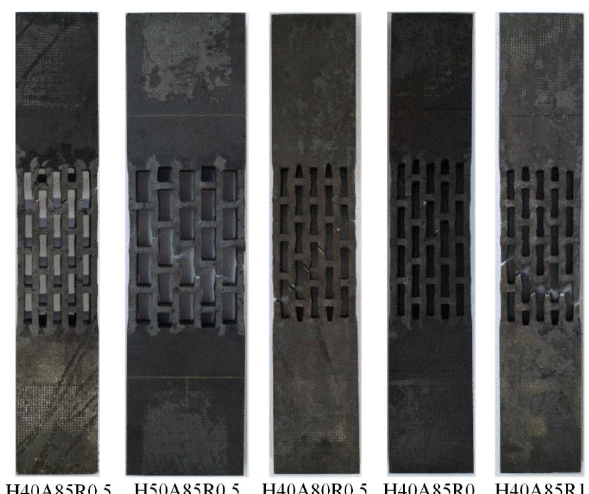
Figure 4. Failure modes of tested specimens. Table 2. Experimental and numerical results of specimens.